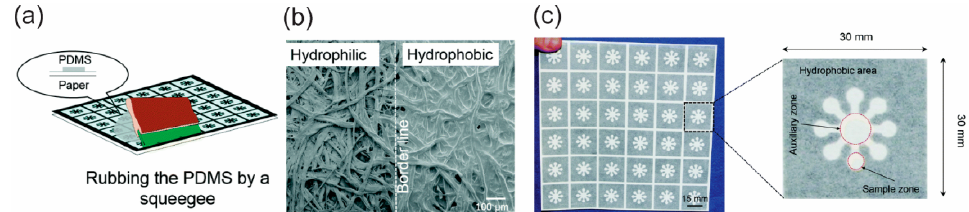
Figure 2. Patterning hydrophobic barriers on paper for fabricating p-CMF devices. ( a ) Screen-printing of polydimethylsiloxane (PDMS ink for patterning PDMS-hydrophobic patterns, ( b ) scanning electron microscope (SEM) images of paper (left) and PDMS-paper (right), and ( c ) fabricated p-CMF devices. Reprinted with permission from the authors of [36]. Copyright 2015 The Royal Society of Chemistry.